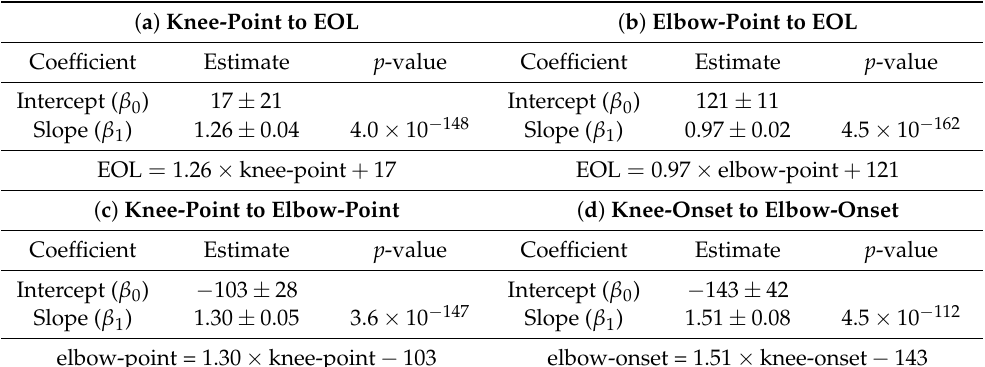
Table 4. Coefficients of four linear regression models relating the knee-point ( a ) and the elbow-point ( b ) to the end of life, the knee-point to the elbow-point ( c ) and the knee-onset to elbow-onset ( d ), respectively. The p -values for β 1 were computed using the Wald test, and the small values allow the rejection of the null hypothesis that a linear relationship does not exist. The 95% confidence intervals for the estimated coefficients are calculated via bootstrapping. The coefficient of determination, R 2 , of these linear regression models is ( a ) 0.9822, ( b ) 0.9896, ( c ) 0.9818 and ( d ) 0.9520; all close to 1, showing that the fitted models explain the observed data